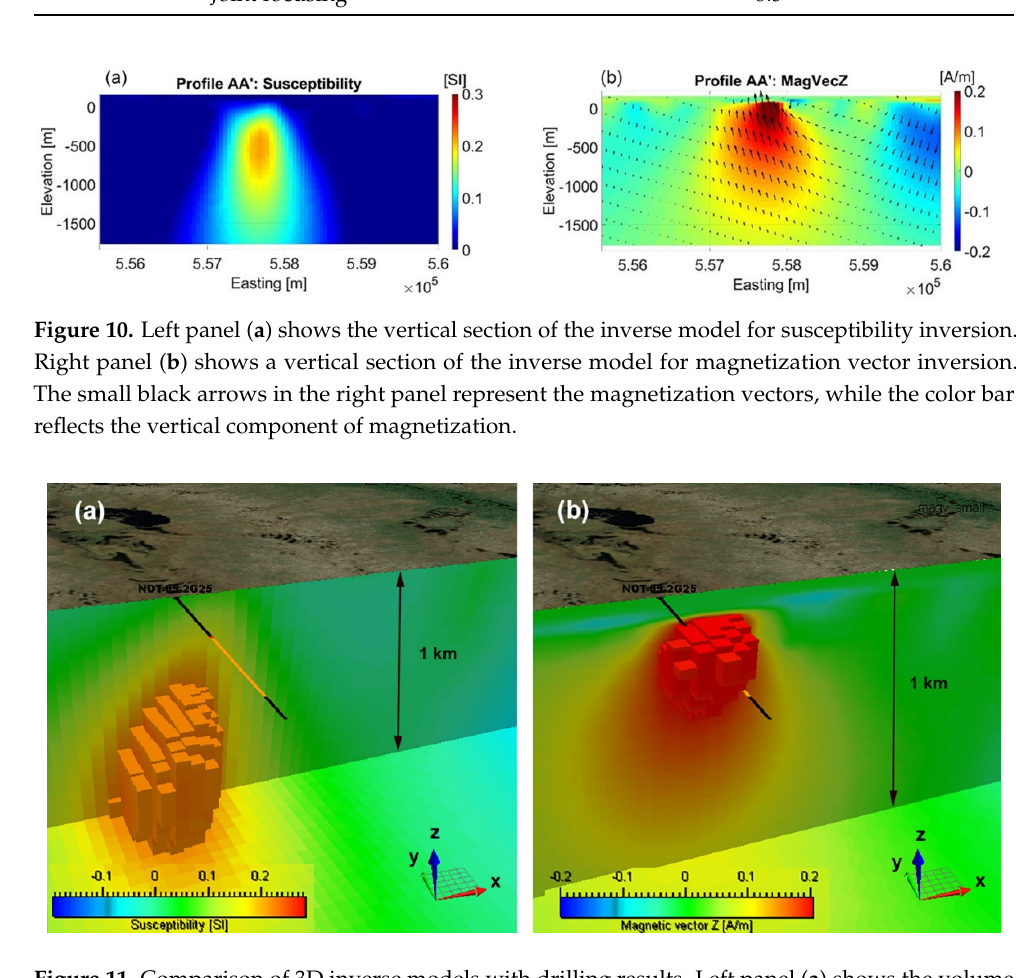
component of the magnetization vector. The black–yellow–black solid line shows the location of the